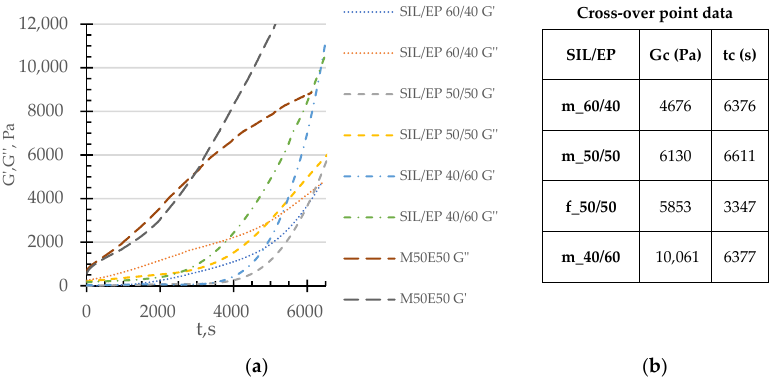
) and 40/60 ( ♦ /+). (cid:65)